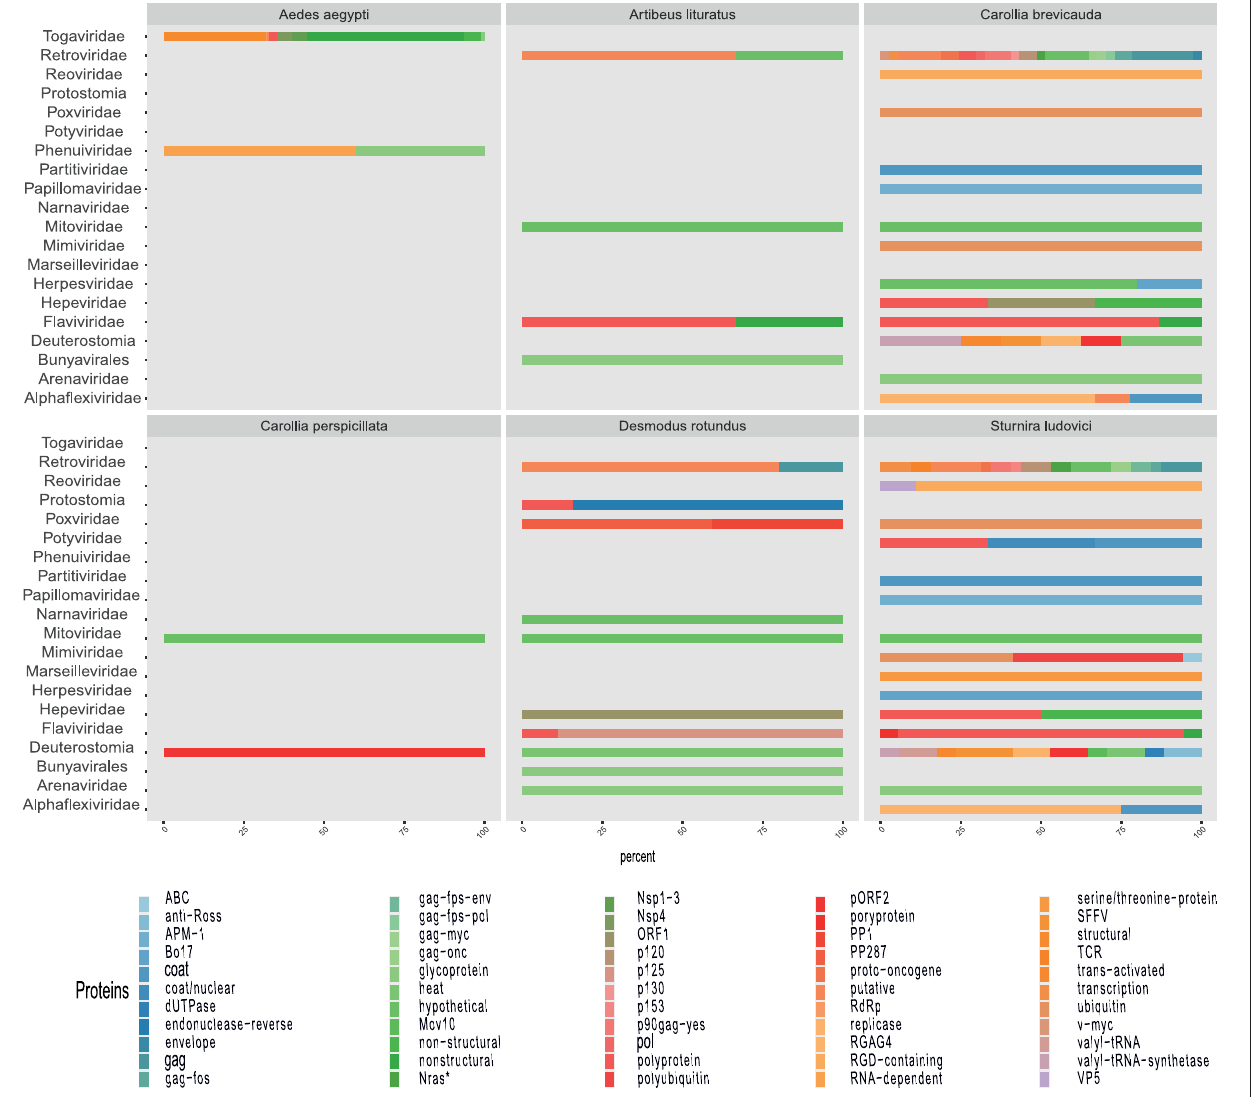
FIGURE5| Heatmapsoftheproportionsofsequencingreads classi fi ed intoviralfamiliesbysampleorigin.Graphs (A and B) correspondtothehighest proportion (families with > 2% of total viral reads by sample) and the lowest proportion of reads (families with < 2% of total viral reads by sample). The top columns